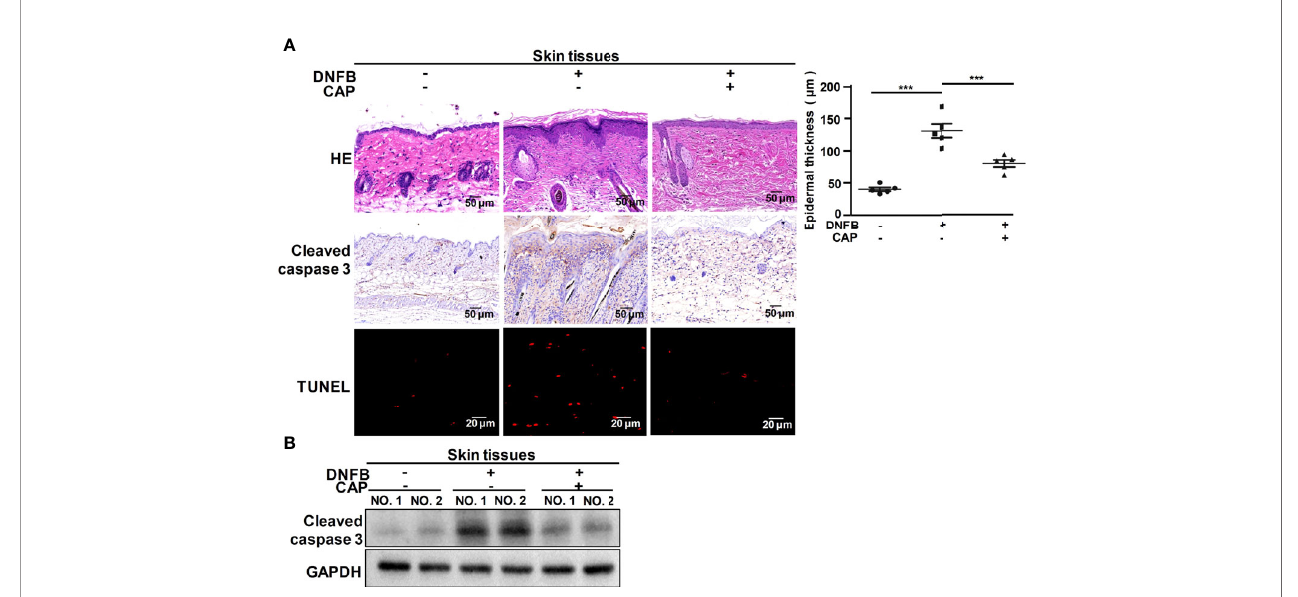
FIGURE 1 | CAP alleviated DNFB-induced skin injury via attenuating apoptosis. DNFB-induced AD mice model was constructed, followed by CAP treatment, n=8. Skin tissues (n=5) were used for HE, immunohistochemical staining of cleaved caspase 3 and TUNEL assay (A) , as well as western blot of cleaved caspase 3 (B) . Epidermal thickness was evaluated. GAPDH serves as control for normalization. Data are expressed as mean ± SEM. ***p <